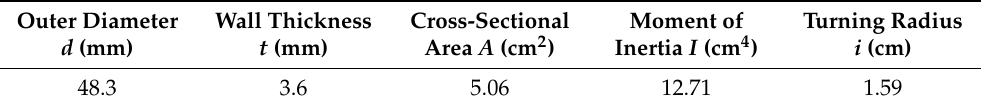
Table 9. Geometric characteristics steel tube section.